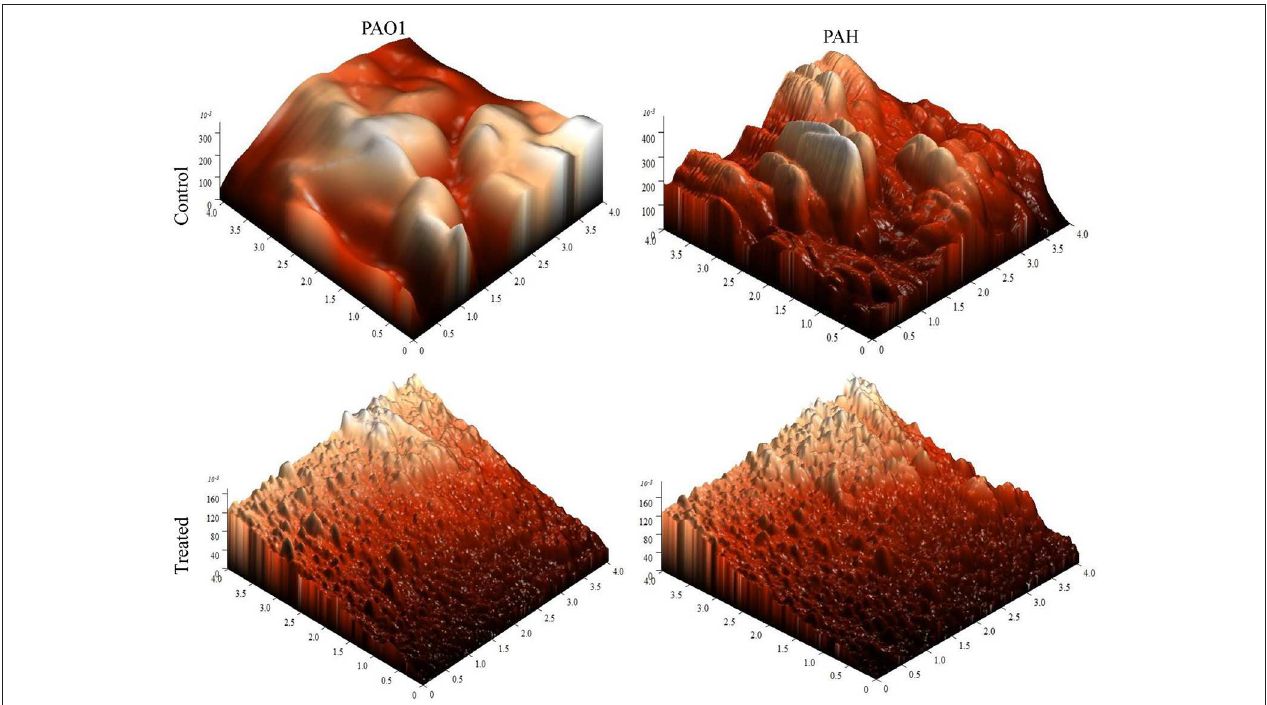
FIGURE 6 | AFM images illustrating the effect of D. tsuruhatensis SJ01 extract on P. aeruginosa biofilms. AFM showed a disrupt surface topology and height distribution profile of the biofilm developed by reference P. aeruginosa strains in the presence of bacterial extract (0.1 mg/ml) compared to the control biofilm.